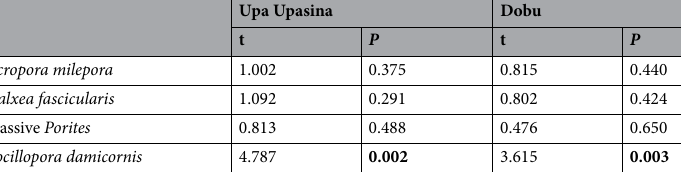
Table 3. PERMANOVA pairwise comparisons for micro-density based between Control and Seep sites within locations (Dobu and Upa Upasina) for the four investigated species. The pairwise test was conducted only for micro-density based on the significant interaction between Site and Species (Table 2). Significant values are reported in bold.